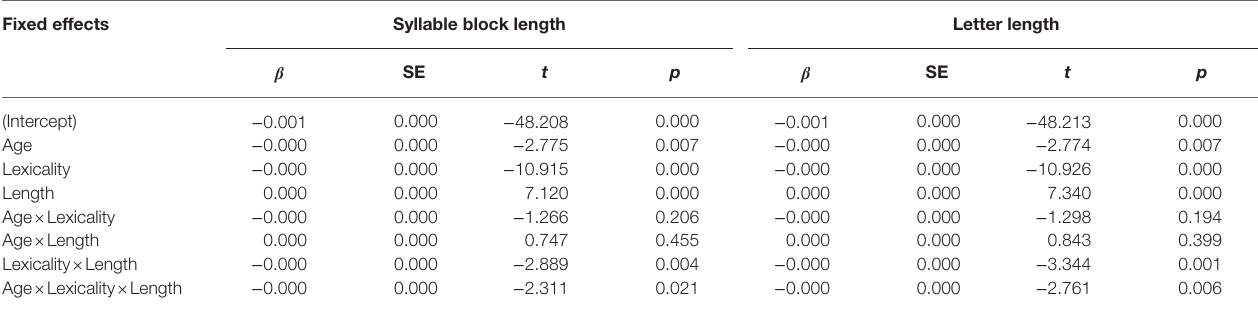
TABLE 7 | Estimates of fixed effects in reading latency: age × lexicality × length. Fixed